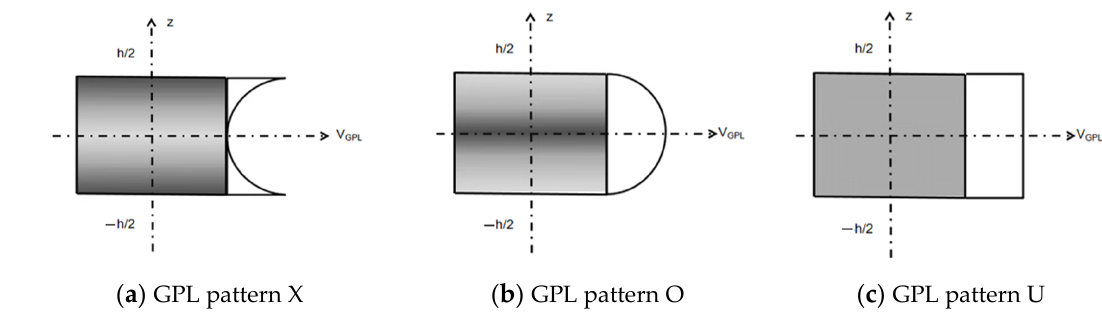
Figure 2. Three types of GPL dispersion pattern.